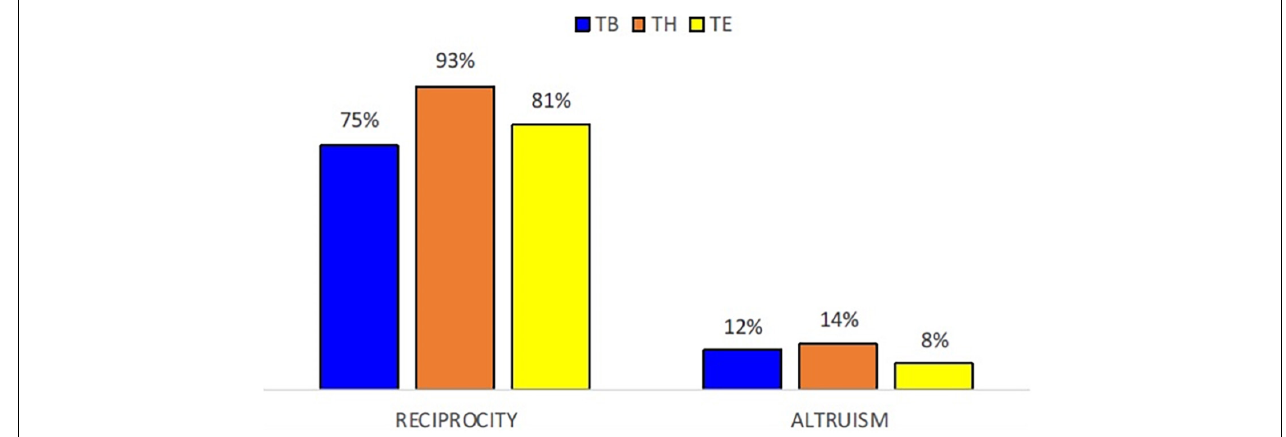
FIGURE 5 | Average levels of reciprocity and altruism in the TG, per